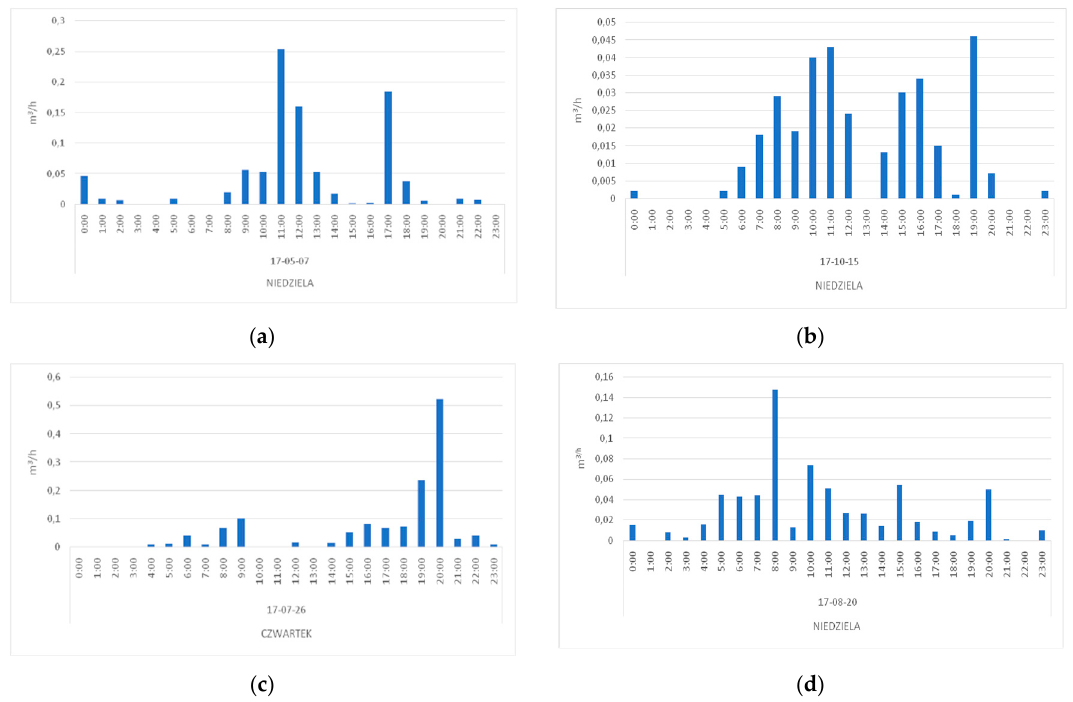
Figure 3. Examples of variability of hourly water consumption in a day with maximum demand in selected single-family houses: ( a ) Building No. 1, ( b ) building No. 6, ( c ) building No. 7 and ( d ) building No. 9.